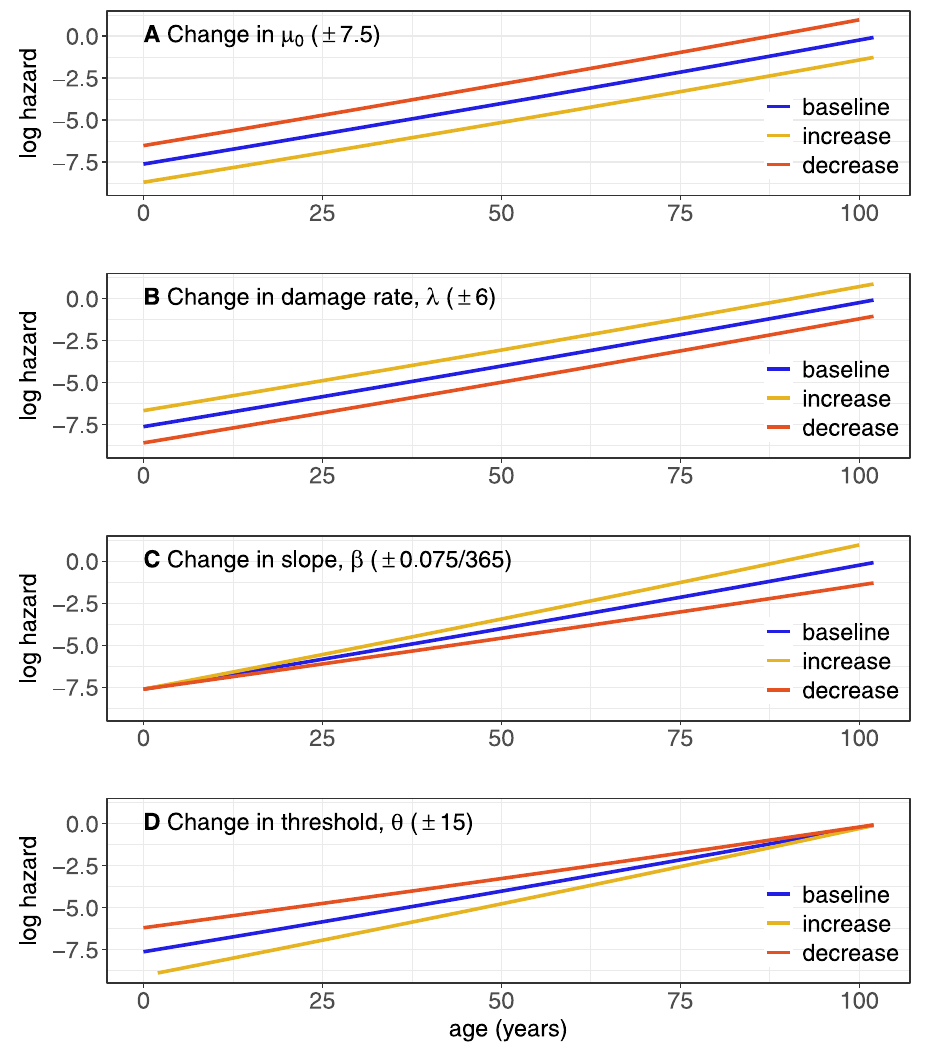
Fig 3. Effects of changes in the parameters on P ( Q � θ ), using Eq 2 with λ = 500, μ 0 = 50, β = 0.485/365, θ = 80.